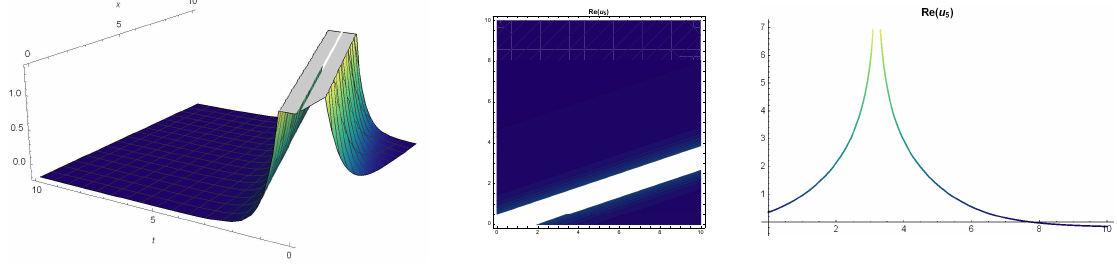
Figure 7. The real part of the 3D, contour and 2D graphics respectively for c 2 = 5, c 1 = − 1, q = − 1, p = − 0.5, w = 3 values of Equation (46).